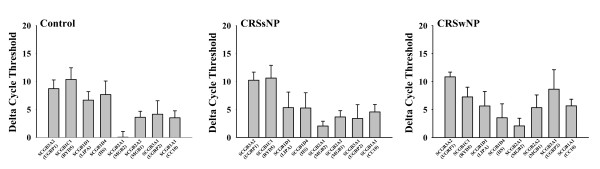
Relative mRNA expression levels of different SCGBs in sinonasal mucosa. The relative expression levels are expressed as ΔCT (ΔCT = the difference in threshold cycles for target and GAPDH). This is a direct reflection of amount of input of target mRNA, and a change of CT value of 1 unit is equal to a doubling, or halving, of the level of target mRNA. The higher the ΔCT value, the lower the level of target mRNA. In control group, n = 16; in chronic rhinosinusitis without nasal polyps (CRSsNP) group, n = 20; and in chronic rhinosinusitis with nasal polyps (CRSwNP) group, n = 20. Results are presented as mean ± SD.